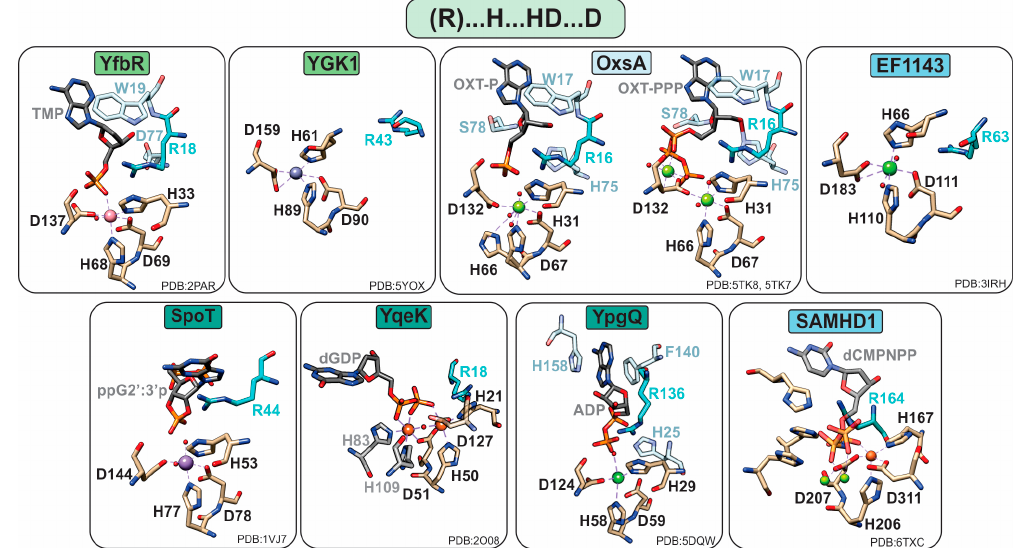
Figure 3. Active sites of HD-domain phosphohydrolases. Mononuclear HD-domain phosphohydrolases utilize a conserved motif “H...HD…D” to bind a variety of metals including cobalt (pink), zinc (purple), magnesium (light green), nickel (dark green), or iron (orange). Small red spheres represent water molecules. The dinuclear phosphatase YqeK harbors two extra histidines between the HD and D residues to stabilize the second metal ion. Phosphatases are classified into mono-, di-, or triphosphohydrolases, labeled in light green, dark green, and blue, respectively. All phosphohydrolases have a conserved arginine (shown in teal), which is located typically three residues prior to the first histidine of the HD motif and in the vicinity of the oxygens of the substrate phosphate group. Other important residues are shown in pale blue and are described in the text.